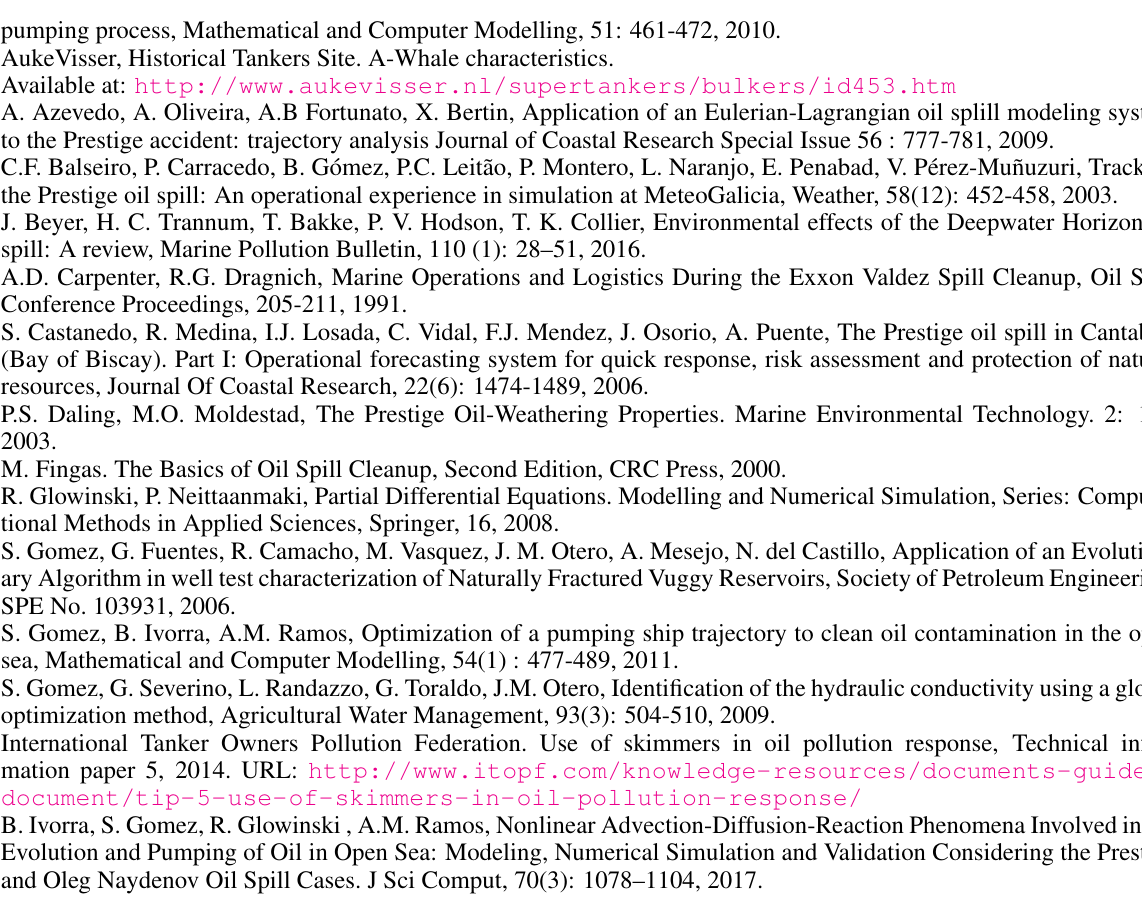
Fig. 11 (Left) Top view and (Right) 3D view of the final oil concentration distribution on 19 November 2002, skimmer ship trajectory (continuous line), final position of the skimmer ship (x) and final position of the Prestige ship (o) for the experiments with two skimmer ships, one following the trajectory generated by OPT-8- (4) and another one following the Prestige ship trajectory. The trajectory of the prestige ship is also presented in dotted line. In the 3D view case, a plane at the same height as the maximum value of the oil concentration is also presented. In this plane the skimmer ship trajectory (continuous line), Prestige ship trajectory (dotted line), final position of the skimmer ship (x) and final position of the Prestige ship (o) are